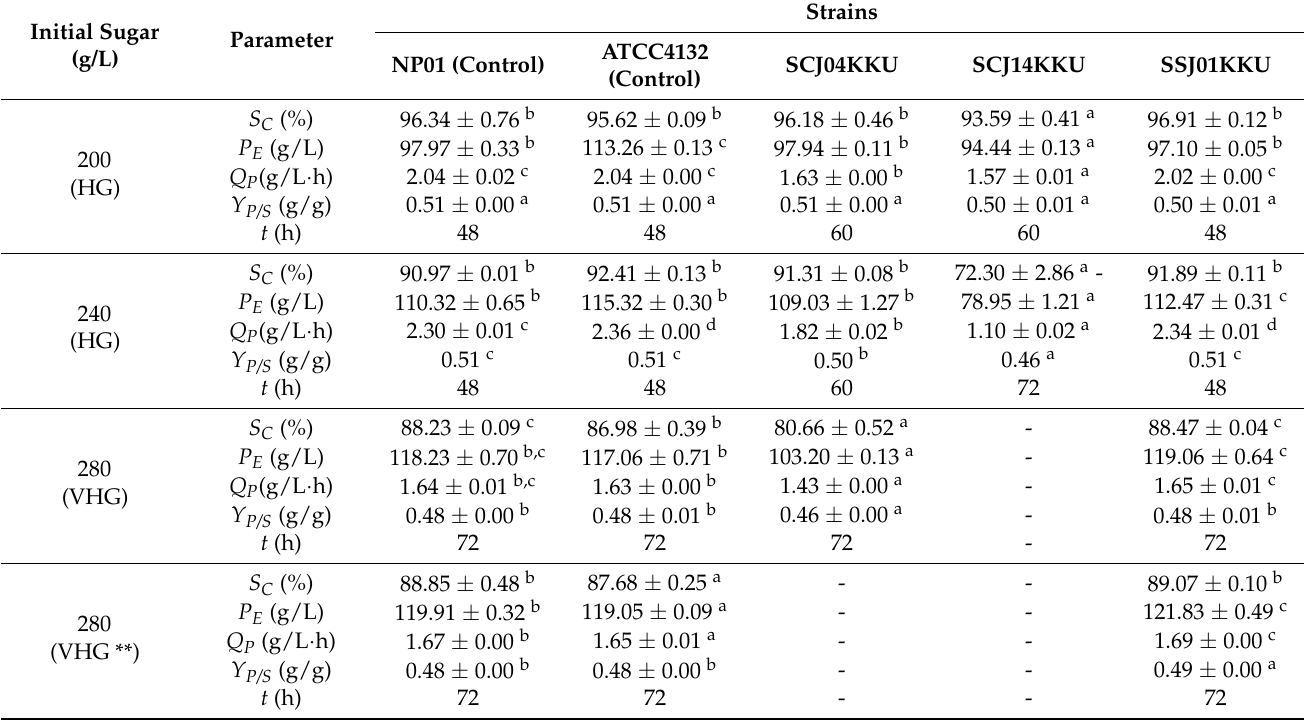
Table 3. Fermentation parameters of batch ethanol production from SSJ media under HG and VHG conditions with urea addition (1.54